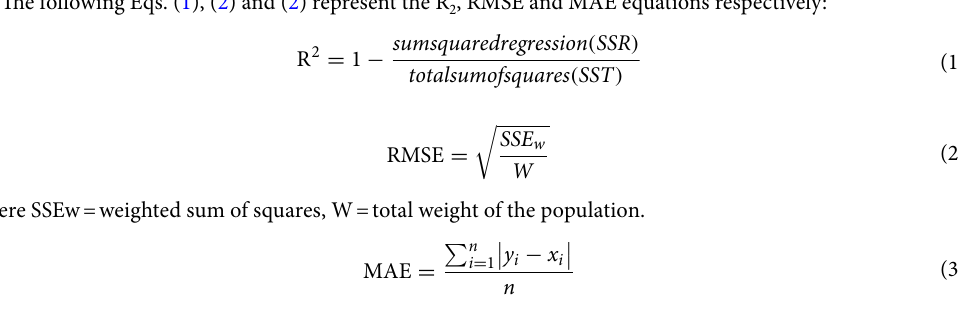
For the PCA regression approach, the packages FactoMineR and factoextra in R programming were used to find 15 most significant wavelengths for each MP dataset through PCA. These 15 significant wavelengths were then randomly split into 70/30 training and testing datasets and then cross-validated. R-squared value (R 2 ), root mean squared error (RMSE) and mean absolute error (MAE) were used as models’ performance metrics. For machine learning, Scikit-Learn software library was implemented in order to identify and select the most significant features (i.e. wavelengths) for each respective microplastic using the feature importance algorithm and Random Regressor algorithm available in the Scikit-Learn library 30 . The feature importance acts as an indicator for each individual contribution of every corresponding feature in a particular classifier 31 . From the regression algorithm selection pipeline, Random Forest (RF) Regressor was used for LDPE, whereas K-nearest neighbor (KNN) Regressor was used for PET and ABS in developing the regression models. The same metrics were (R 2 , RMSE, MAE) generated through this approach to evaluate the models’ performance. The performance metrics generated by both approaches were then compared. The following Eqs. (1), (2) and (2) represent the R 2 , RMSE and MAE equations respectively: